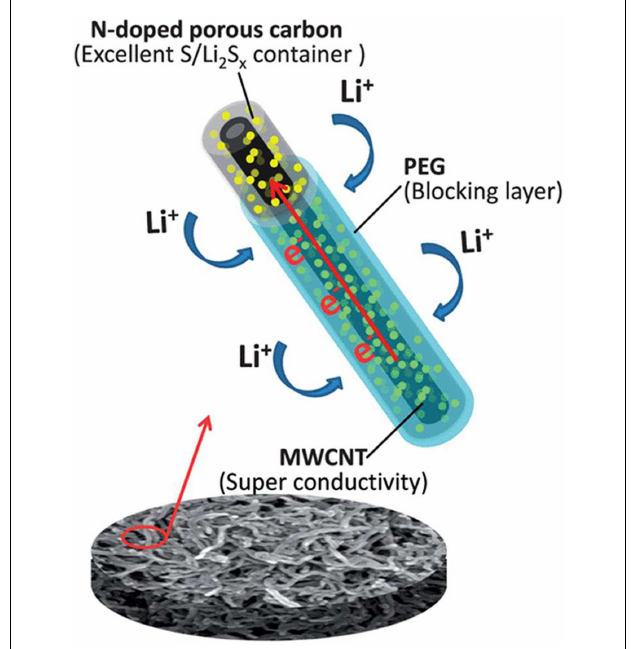
FIGURE 5 | Schematic configuration of MWCNT@S/NPC@PEG (Li et al., 2014b) .